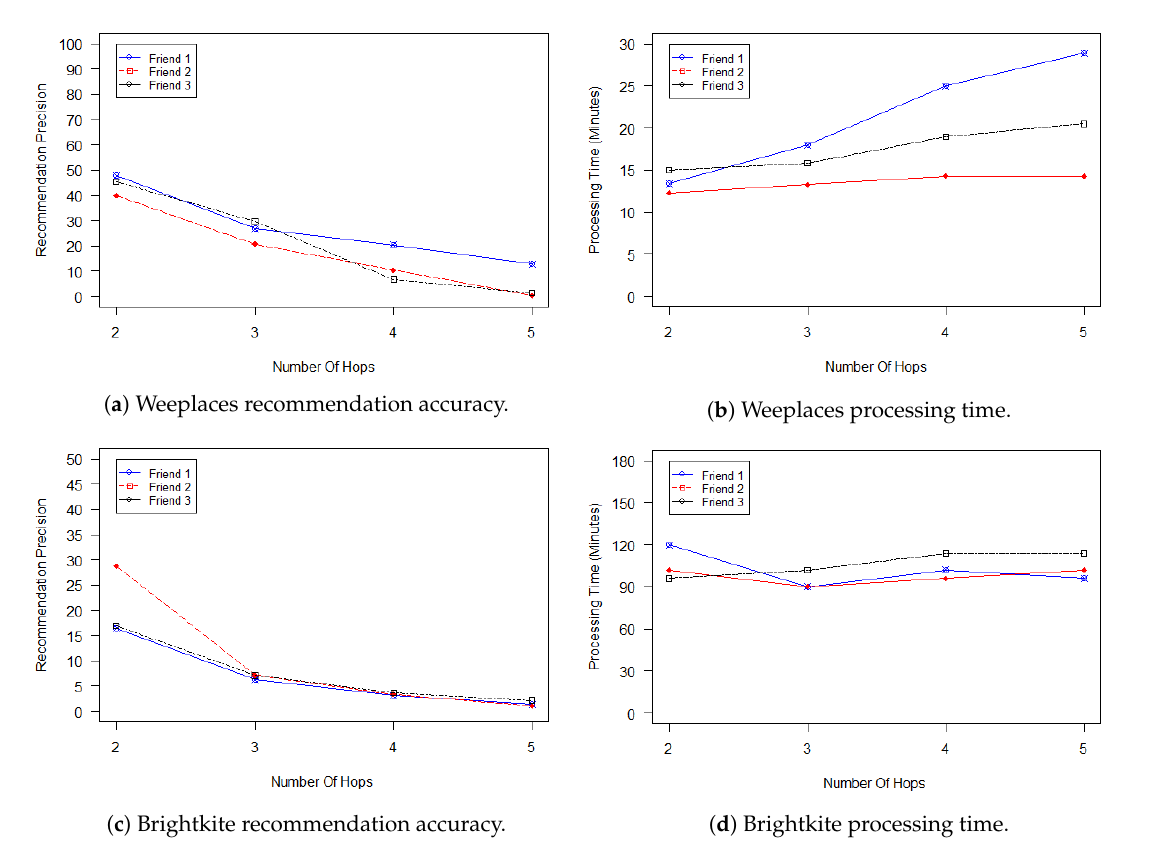
Figure 13. Friend of friend